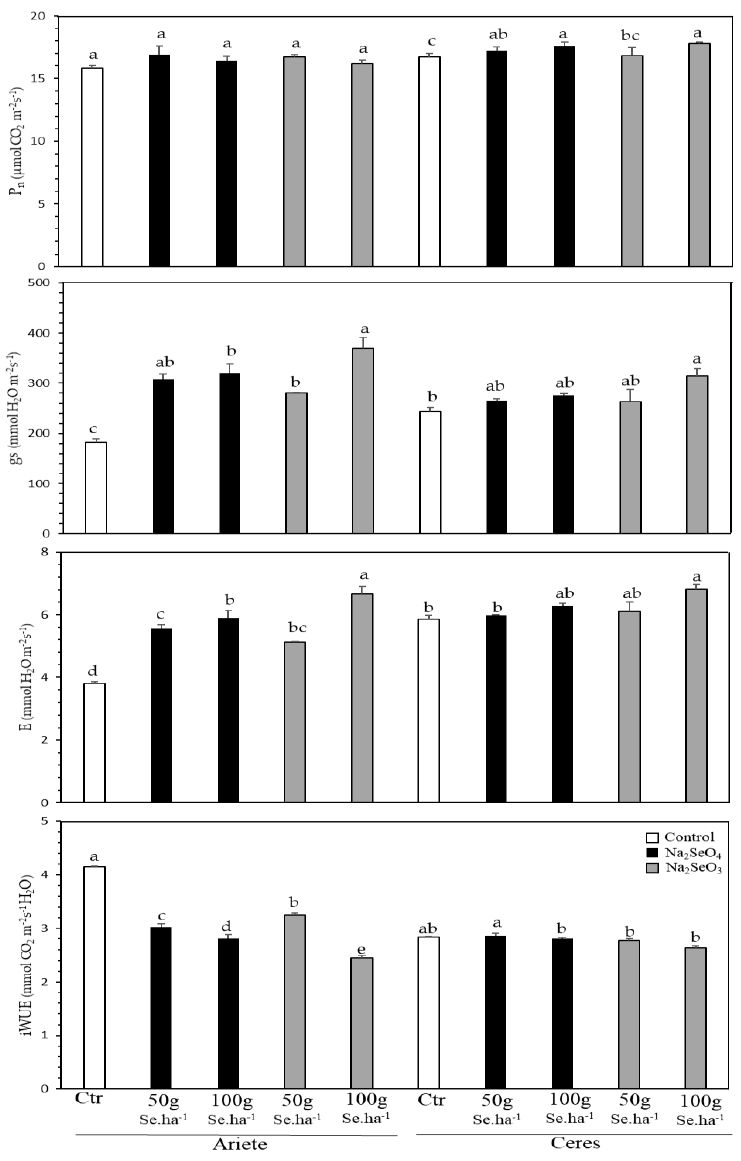
Figure 1. Leaf gas exchange parameters—net photosynthesis (P n ), stomatal conductance to water vapor (g s ), transpiration (E) rates, and instantaneous water use efficiency (iWUE) in leaves of O. sativa , cultivars Ariete and Ceres. Different letters indicate significant differences between treatments, for each cultivar ( p ≤ 0.05); average ± standard errors ( n = 4−6).